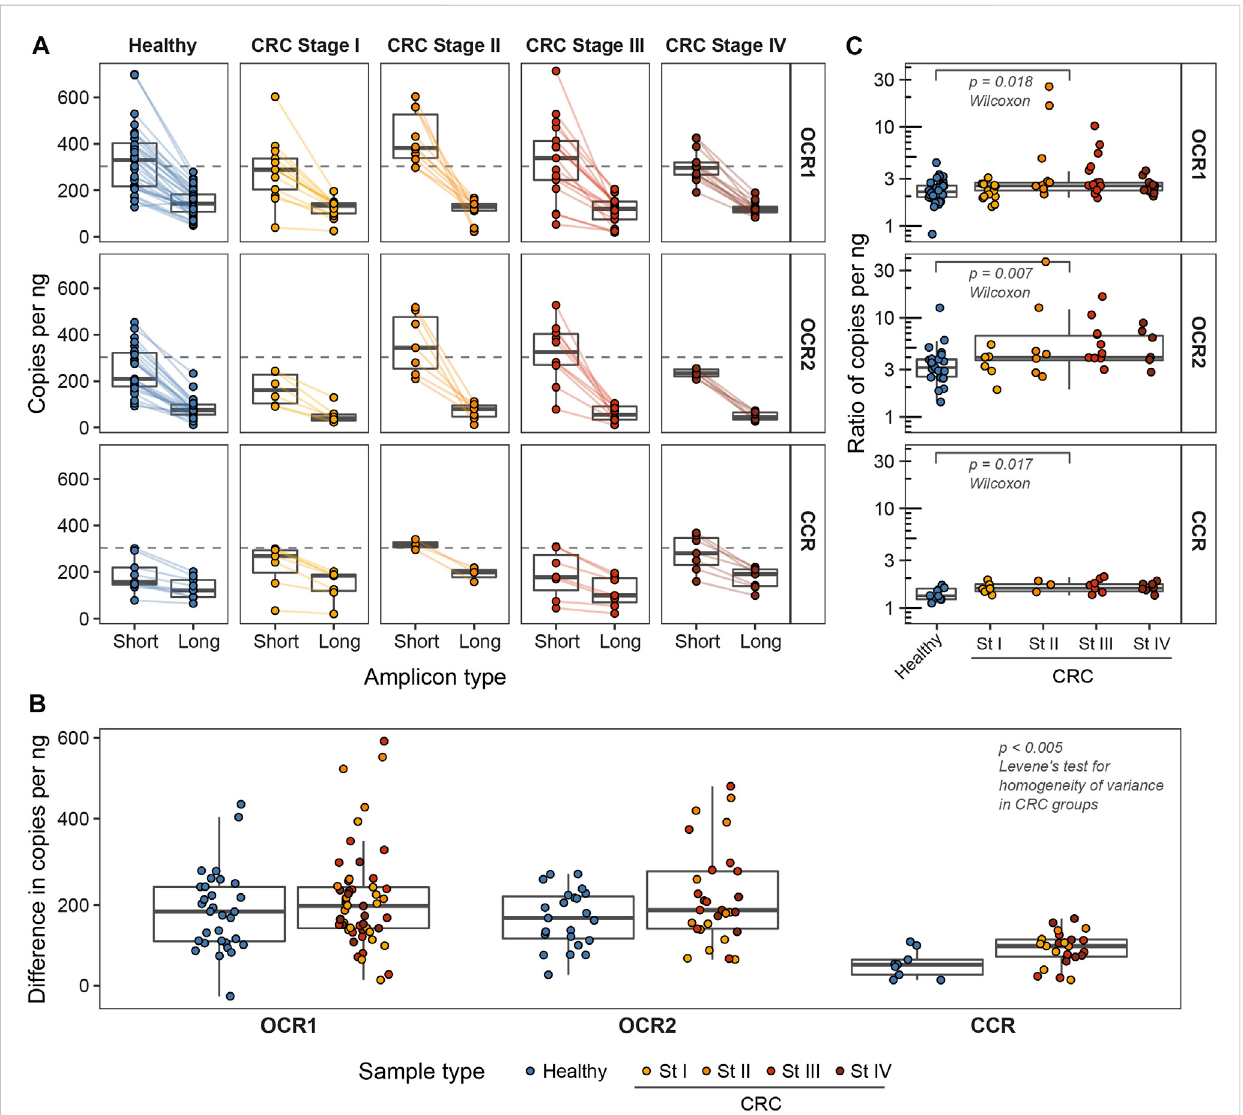
FIGURE 2 The number of cfDNA copies of studied lengths per nanogram of input DNA in OCR1, OCR2, and CCR. (A) The number of cfDNA copies estimated fromddPCR.Coloredlinesconnectthetwoestimatesforasingle sample.Dashedlinesmarkthetheoretical numberofcopiesin1 ngofhumangenomic DNA (approx. 303 copies/ng). (B) Ratios of numbers of short to long cfDNA copies per nanogram. (C) Differences in absolute numbers of short and long cfDNA copies per